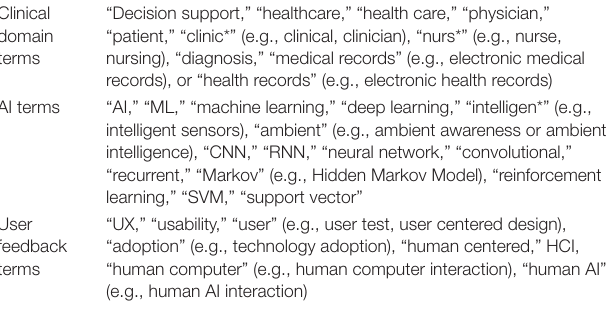
TABLE 1 | Three categories of search criteria used to identify